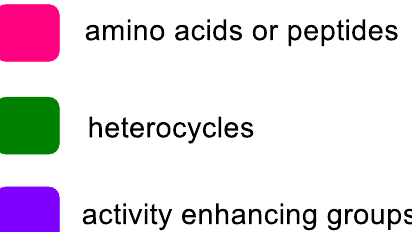
Figure 11. Colour coding used in this article.